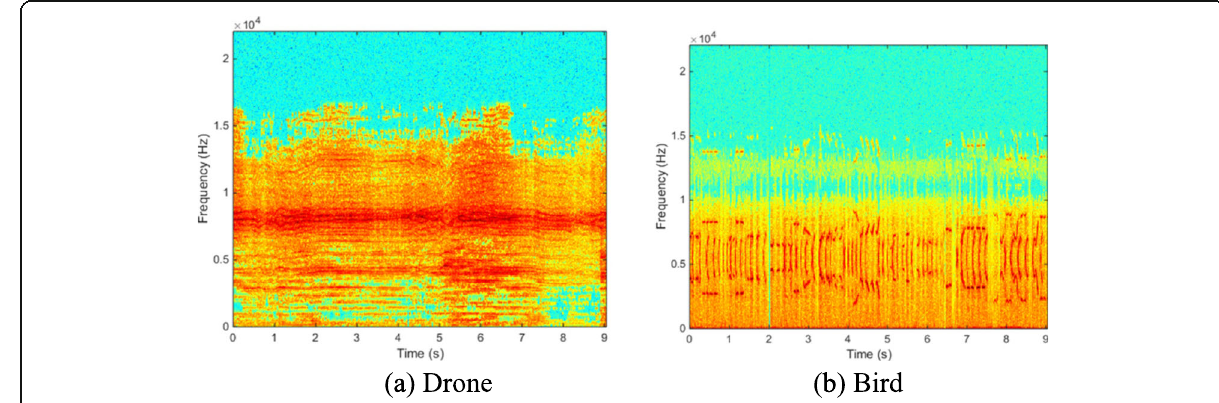
Fig. 11 Spectrogram of drone and bird sounds